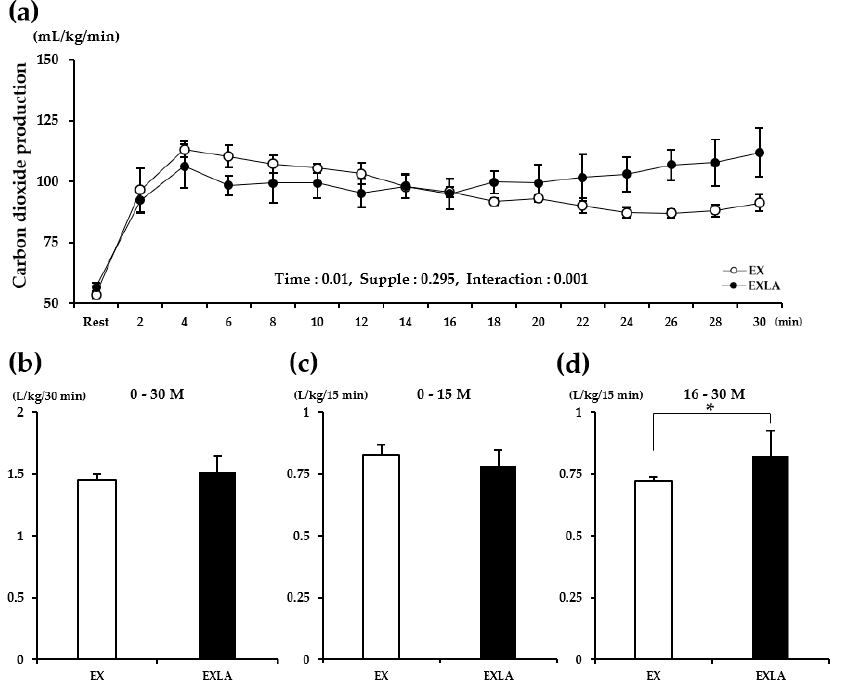
Figure 2. Changes in VCO 2 during exercise. ( a ) VCO 2 changes over time for 30 min; ( b ) total VCO 2 for 30 min; ( c , d ) total VCO 2 for 0–15 min (0–15 M) and 16–30 min (16–30 M), respectively. Supple, supplement effect; Inter, interaction effect; VCO 2 , carbon dioxide production; EX, exercise control group; EXLA, exercise with lactate intake group. Values represent the mean ± standard deviation ( n = 8). * p < 0.05.